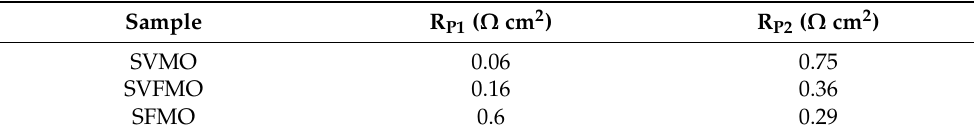
Figure 4. ( a ) EIS of symmetric cells with SVFMO, SVMO and SFMO as working electrodes tested at 750 − 850 °C in H 2 . ( b ) the fitting EIS (testing at 850 °C) to analyze the contribution of R P1 and R P2 for symmetric cells ( c − e ) the single cells with SVMO, SVFMO and SFMO as anodes and with H 2 as fuel gas were evaluated by impedance spectra under OCV condition at 750 − 850 °C (illustrations show the proportions of R ohm and R P ). Table 2. the fitting EIS (testing at 850 °C) of R P1 and R P2 for symmetric cells.